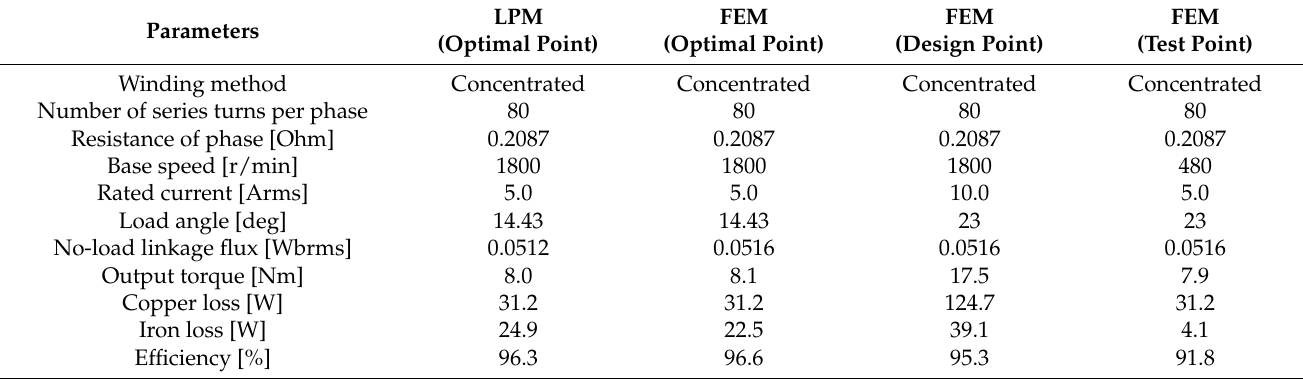
Table 3. Result of analysis using LPM and FEM for a six-phase